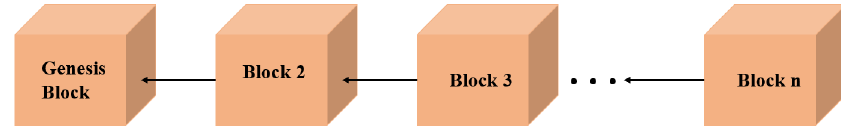
Figure 8. Genesis block in a blockchain.